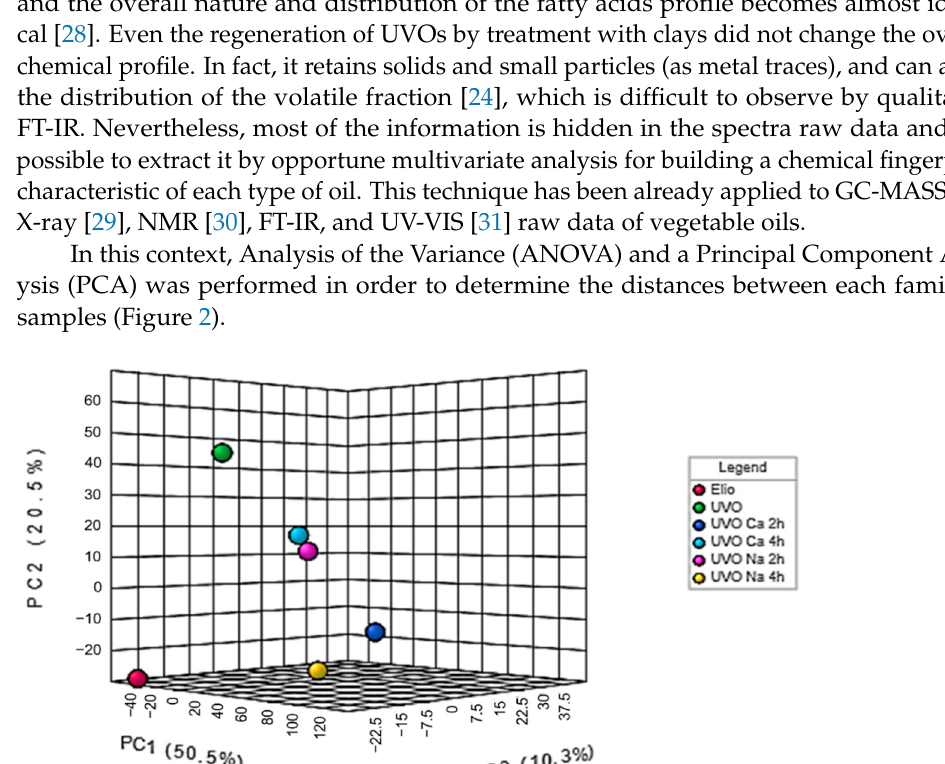
Table 1. Physicochemical parameters for samples of edible oil (EO), UVO, Na, and Ca treated oils. EO